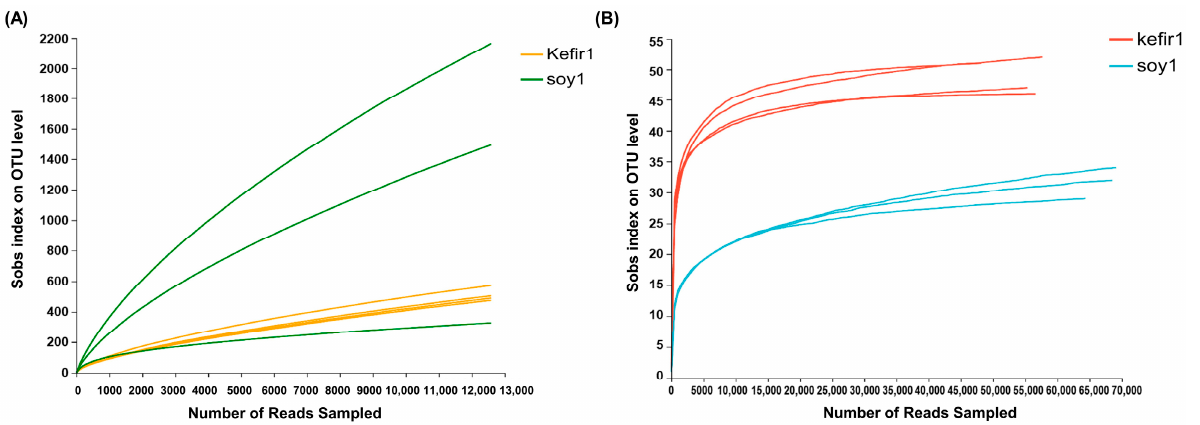
Figure 1. Rarefaction curves of bacterial ( A ) and fungal ( B ) communities in kefir grains and soybean kefir grains.